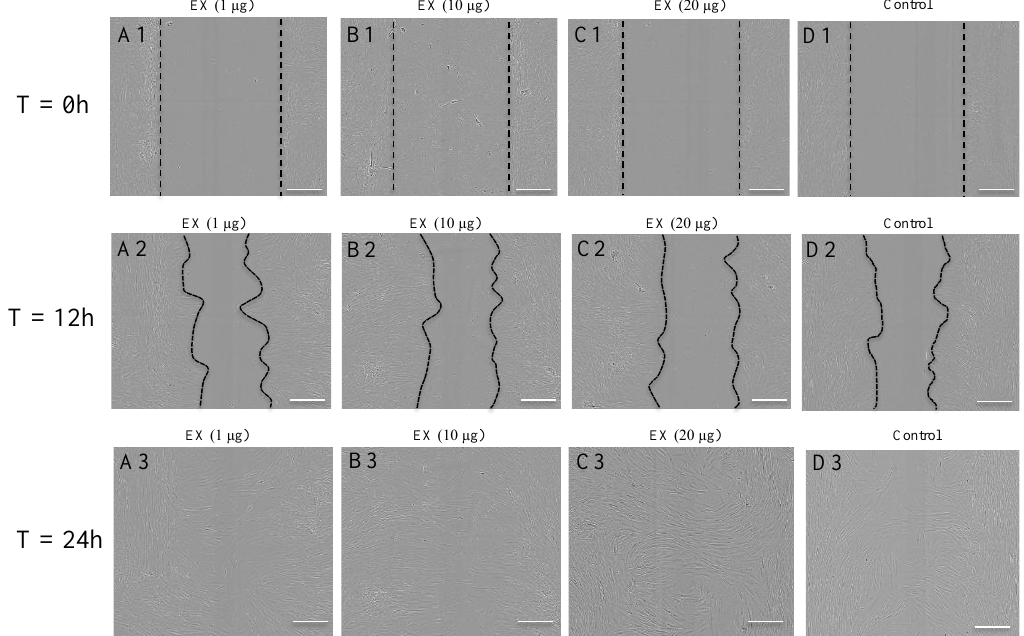
Figure 7. Primary keratinocyte-derived EXs facilitate migration of dermal fibroblasts in 2D culture. Isolated primary keratinocyte-derived EXs were added to scratch-wounded primary fibroblast cultures to a final total EV protein concentration of 1 µ g, 10 µ g or 20 µ g / 0.1mL depleted media. Fibroblasts cultured within depleted media only served as controls. The wounded fibroblast cultures were incubated at 5% CO 2 and 37 ◦ C and allowed to migrate for 24 h in the presence or absence of primary keratinocyte-derived EXs with images captured at 6 hourly intervals. Representative images were extracted from the captured IncuCyte TM images at ( A1 , B1 , C1 , D1 ) T = 0 h; ( A2 , B2 , C2 , D2 ) T = 12 h; and ( A3 , B3 , C3 , D3 ) T = 24 h. Images were captured using a 4X objective. The scale bar = 300 µ m and the dotted lines represent the wound